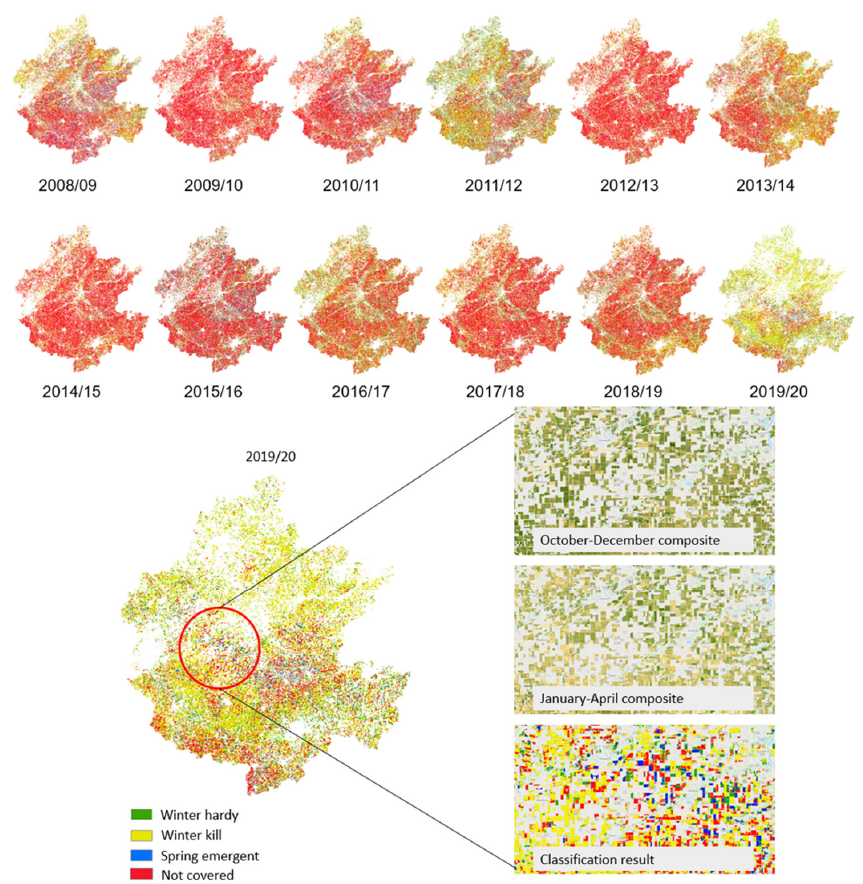
Although the total cover crop area increased between 2008/09 and 2010/11, there Figure 5. ( Top ) Cover crop maps for the Maumee River Watershed between 2008/2009 to 2019/2020, and ( bottom ) cover lacked a consistent increase in annual cover crop areas between 2008/09 and 2019/20 in crop classes for 2019/2020 along with two seasonal composites and classification results for a small section of an area in the general. Additionally, only 0.3% of the total watershed areas was consistently planted in MRW to illustrate the process. Note: seasonal composites are shown using a natural color display of median of red, green, cover crops for 12 years, with 20% of areas for more than five years and more than 50% and blue bands. areas for less than five years.